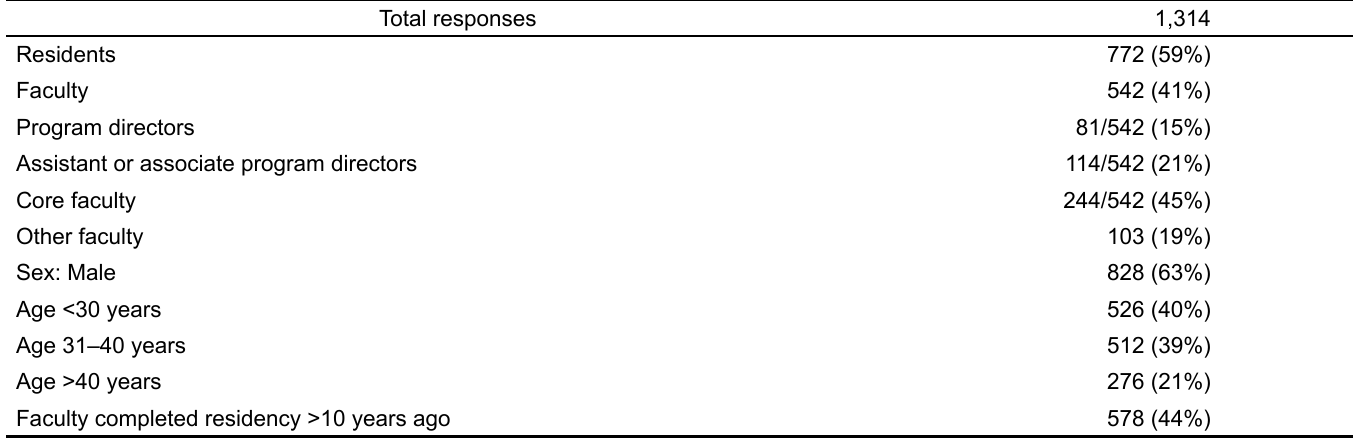
Table 1. Demographics.